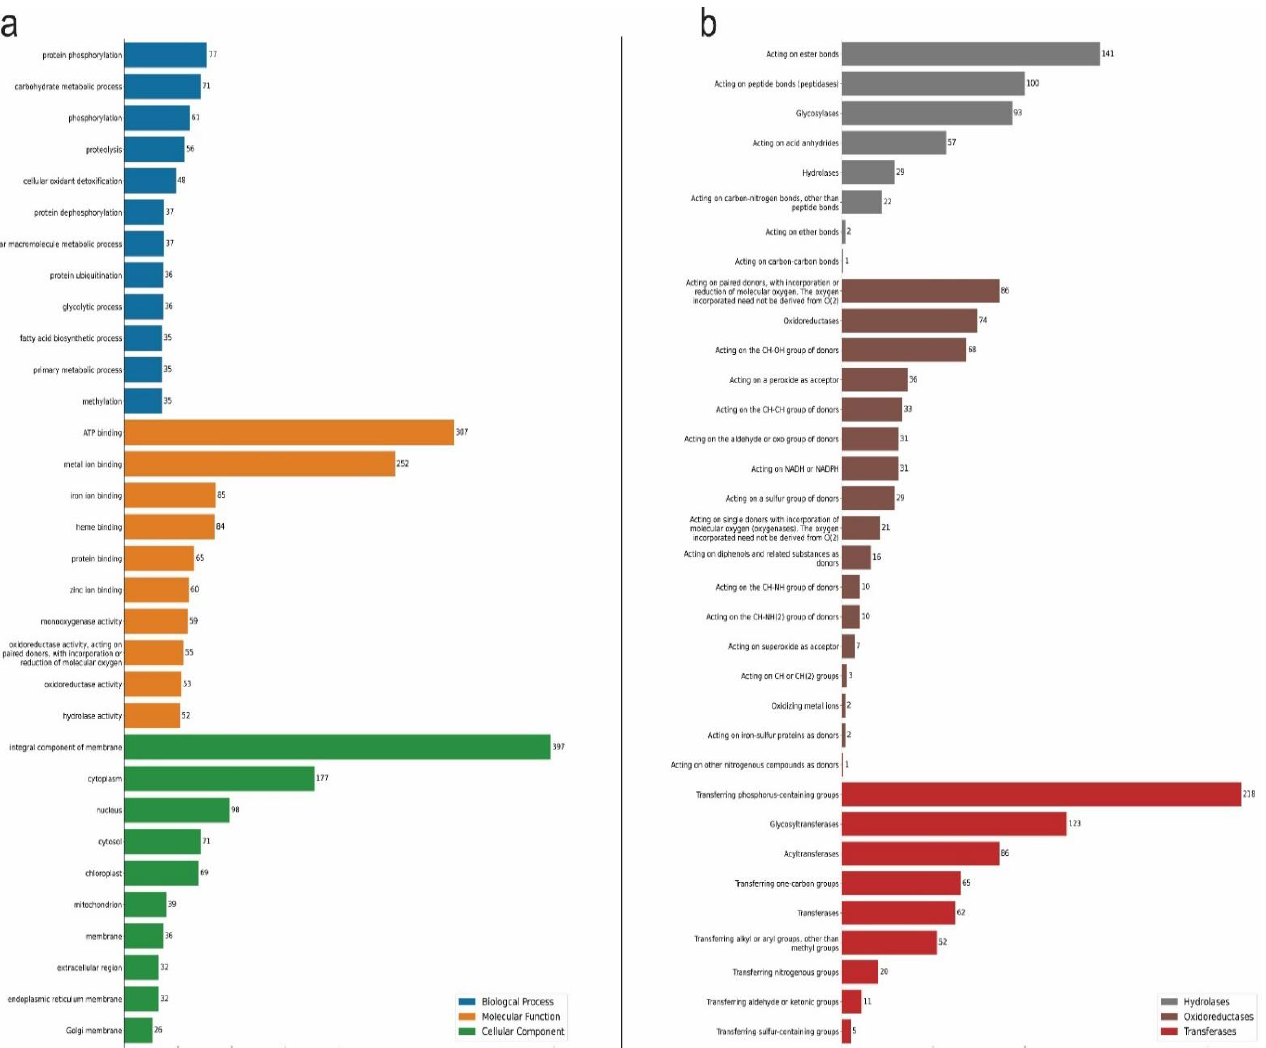
Figure 1. Gene Ontology (GO) annotation classification statistics graph from full-length transcriptome in the leaves of young oil palm plants under drought stress. Classified accordingly to biological process, cellular component, and molecular function ( a ); and to chemical reactions by which proteins are classified according to EC ( b ). Only the most populated groups per GO term, and only the three prevalent classes of enzymes are shown. Numbers represent the amount of positive hits.